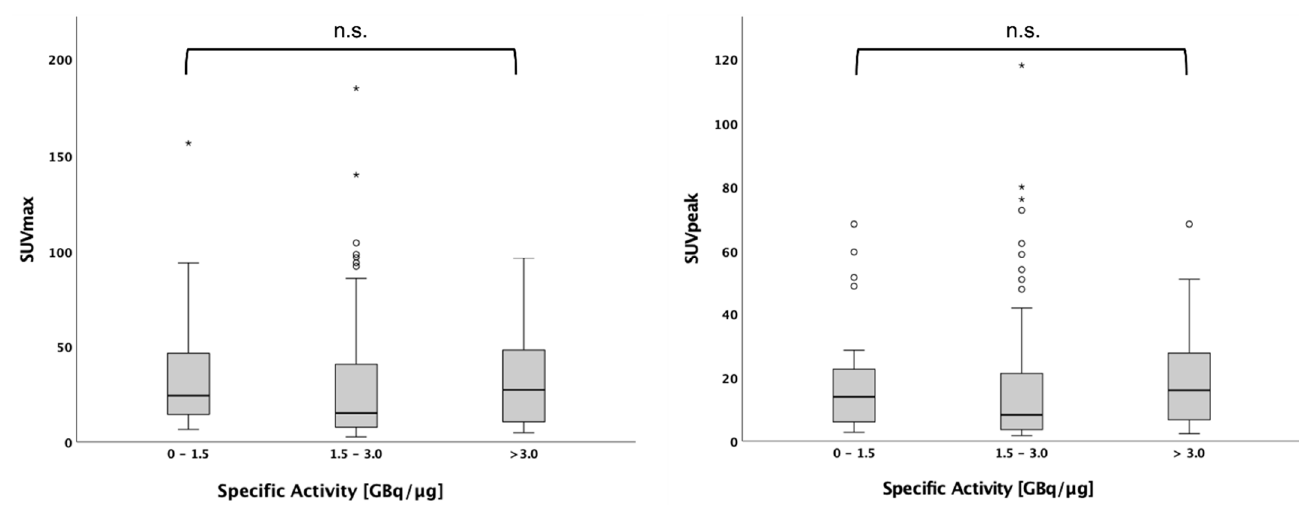
Figure 1. SUVmax and SUVpeak do not depend on specific activity. SUVmax and SUVpeak of the hottest tumor lesion, represented in boxplots with outliers, are not significantly different between patients injected with [ 18 F]F PSMA 1007 with a specific activity between 0–1.5 GBq/µg, 1.5–3.0 GBq/µg and above 3.0 GBq/µg.